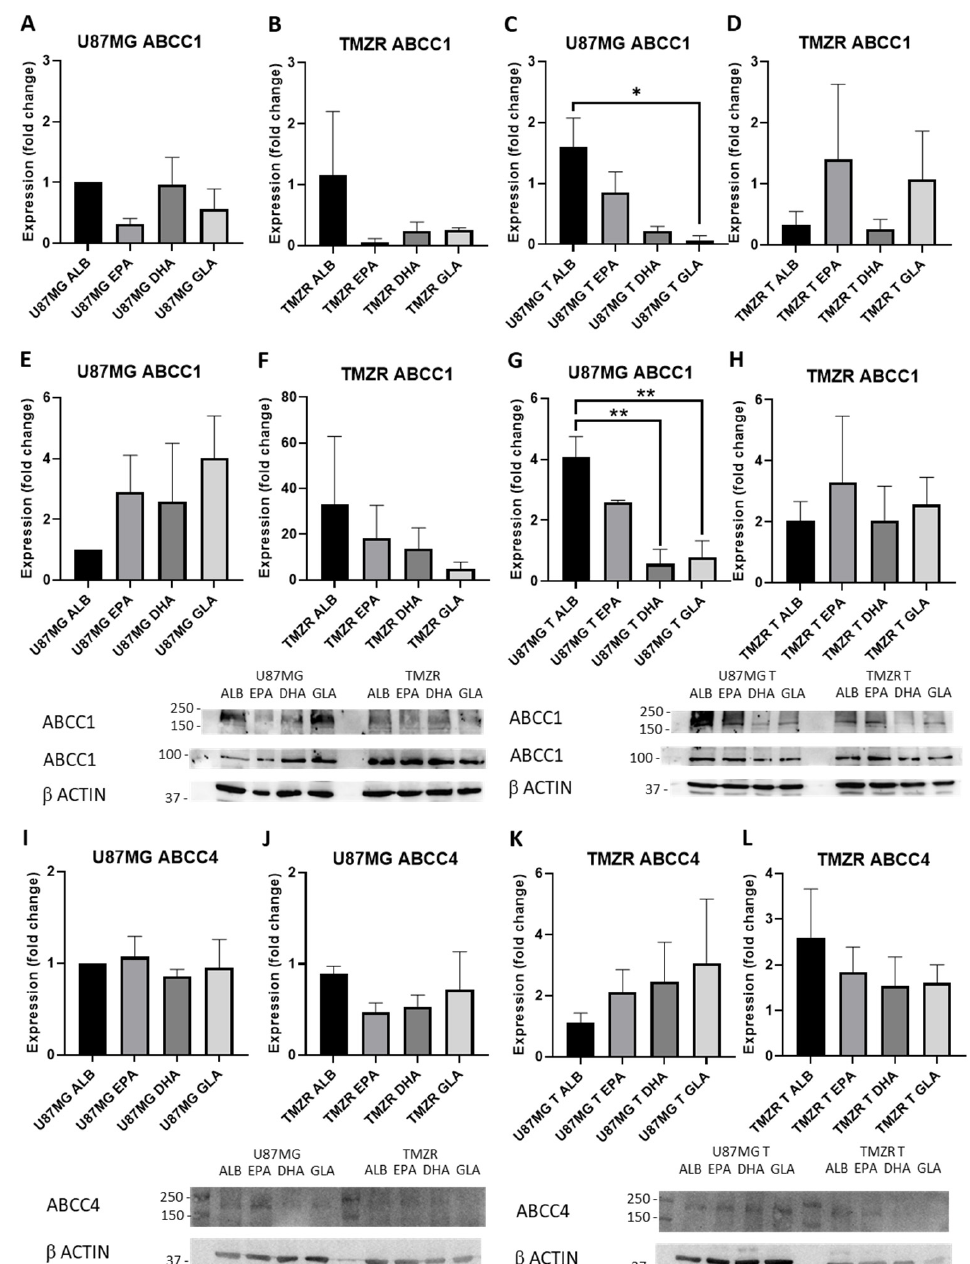
Figure 10. Effects of gamma-linolenic acid (GLA), eicosapentaenoic acid (EPA), and docosahex- aenoic acid (DHA) on protein expression of ABCC1 and ABCC4 transporters: ( A – D ) ABCC1 190KDa band in ( A ) U87MG; ( B ) TMZR; ( C ) U87MG + 25 μ M TMZ; ( D ) TMZR + 25 μ M TMZ; ( A – D ) normalized against U87MG ALB expression. ( E – H ) ABCC1 100KDa band in ( E ) U87MG; ( F ) TMZR; ( G ) U87MG + 25 μ M TMZ; ( H ) TMZR + 25 μ M TMZ; ( E – H ) normalized against U87MG ALB expression ( I – L ) ABCC4 170KDa band in ( I ) U87MG; ( J ) TMZR; ( K ) U87MG + 25 μ M TMZ; ( L ) TMZR + 25 μ M; ( I – L ) normalized against U87MG ALB expression. Data are presented as mean ± SEM, N = 3. Differences were considered significant at p < 0.05. * = p < 0.05; ** = p <